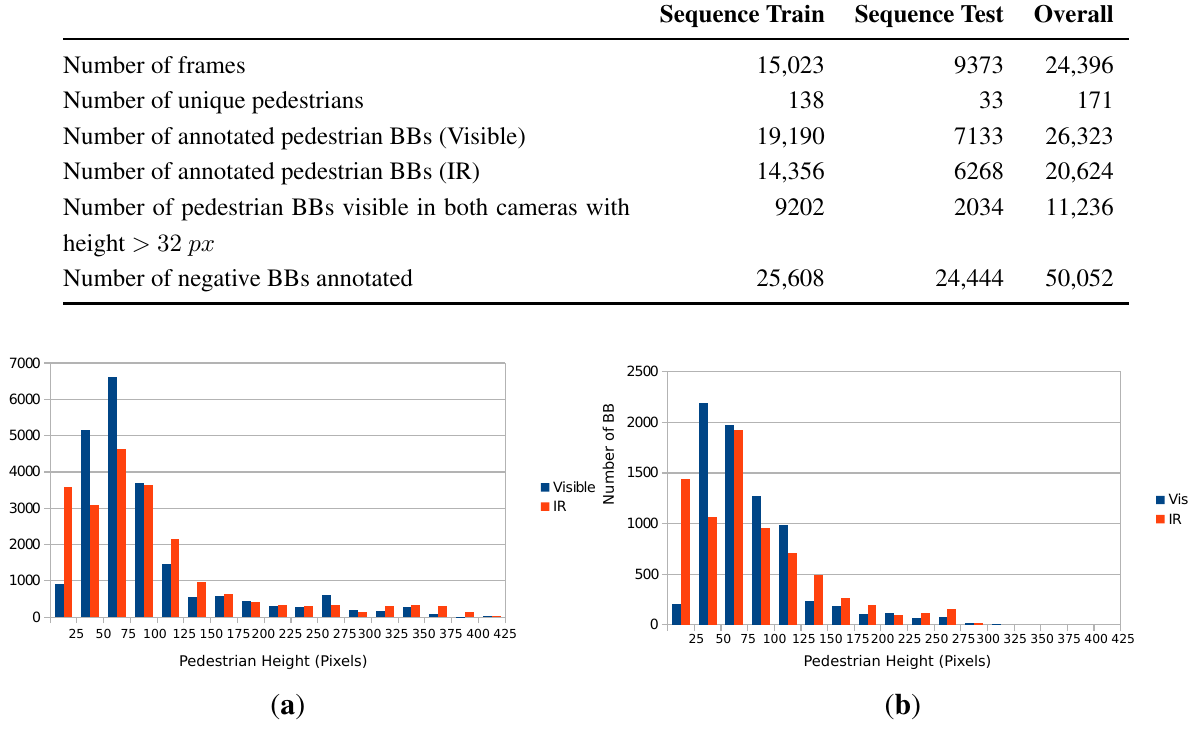
Figure 3. Pedestrian height distribution of training ( a ) and testing sets ( b ) for